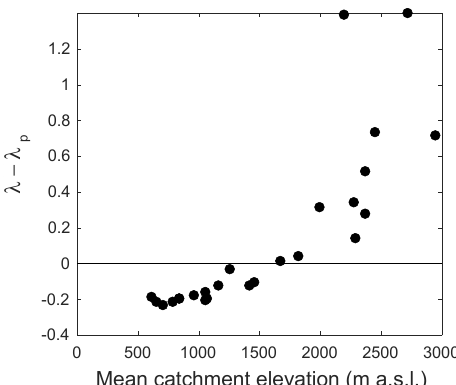
Figure 6. Difference between λ and λ p as a function of mean catch- ment